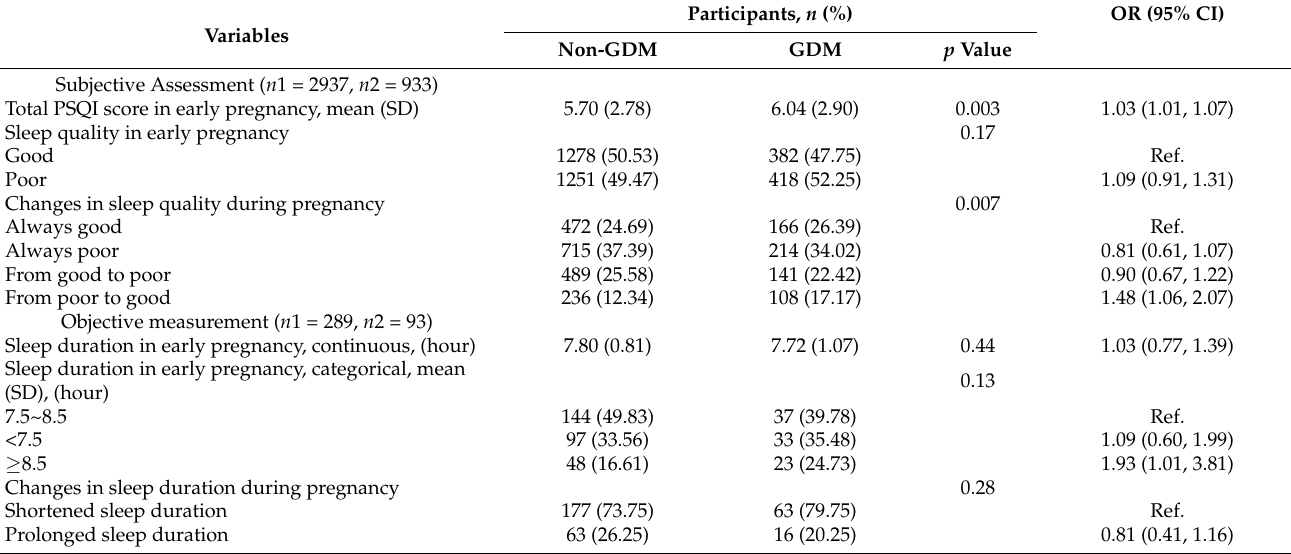
Table 2. Distribution of maternal sleep patterns in early pregnancy and their changes during preg- nancy in the GDM subgroup and the risk of sleep patterns during pregnancy on GDM. Participants, n Variables